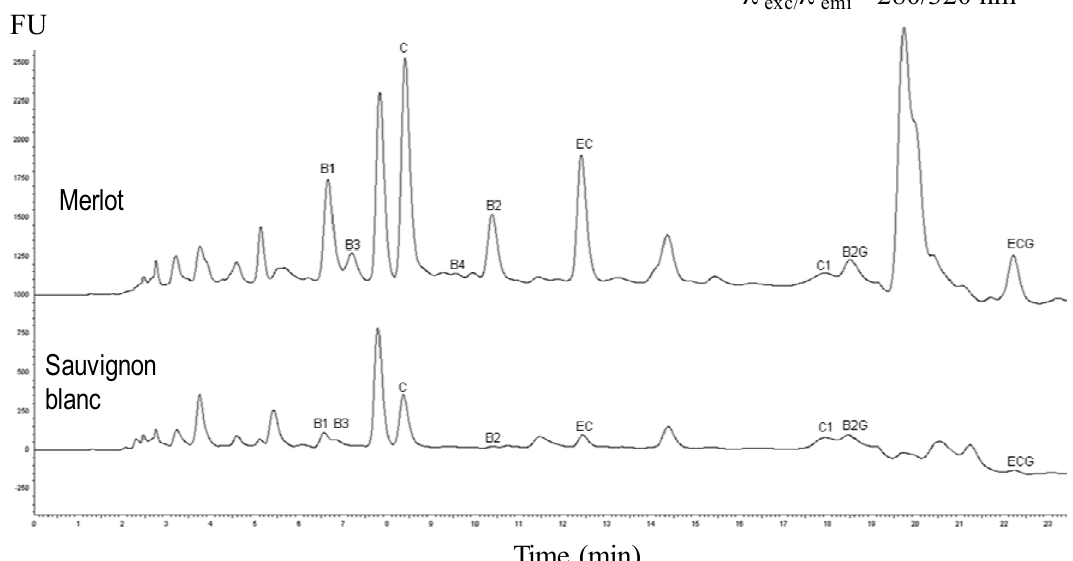
Figure 4. HPLC-Fluo chromatograms of a Merlot and a Sauvignon blanc wine. C: (+)-catechin, EC: ( − )-epicatechin, ECG ( − )-epicatechin-3- O -gallate, B1: procyanidin dimer B1, B2: Procyanidin B2, B3: Procyanidin dimer B3, B4: Procyanidin dimer B4, C1: Procyanidin trimer C1, B2G: procyanidin dimer B2 gallate. Adapted from Silva et al . (2012)